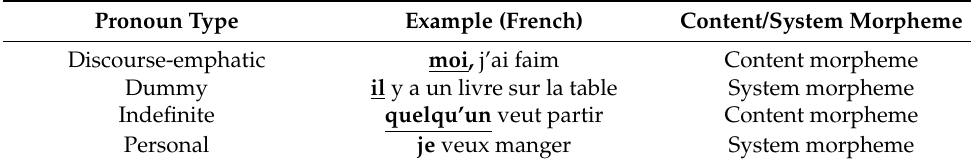
Table 1. Types of pronouns (in boldface and underlined) according to the MLF. Pronoun